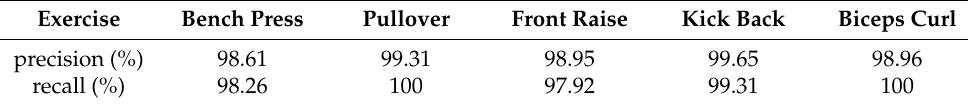
Figure 6. Performance in exercise recognition. Table 1. Recognition of exercise